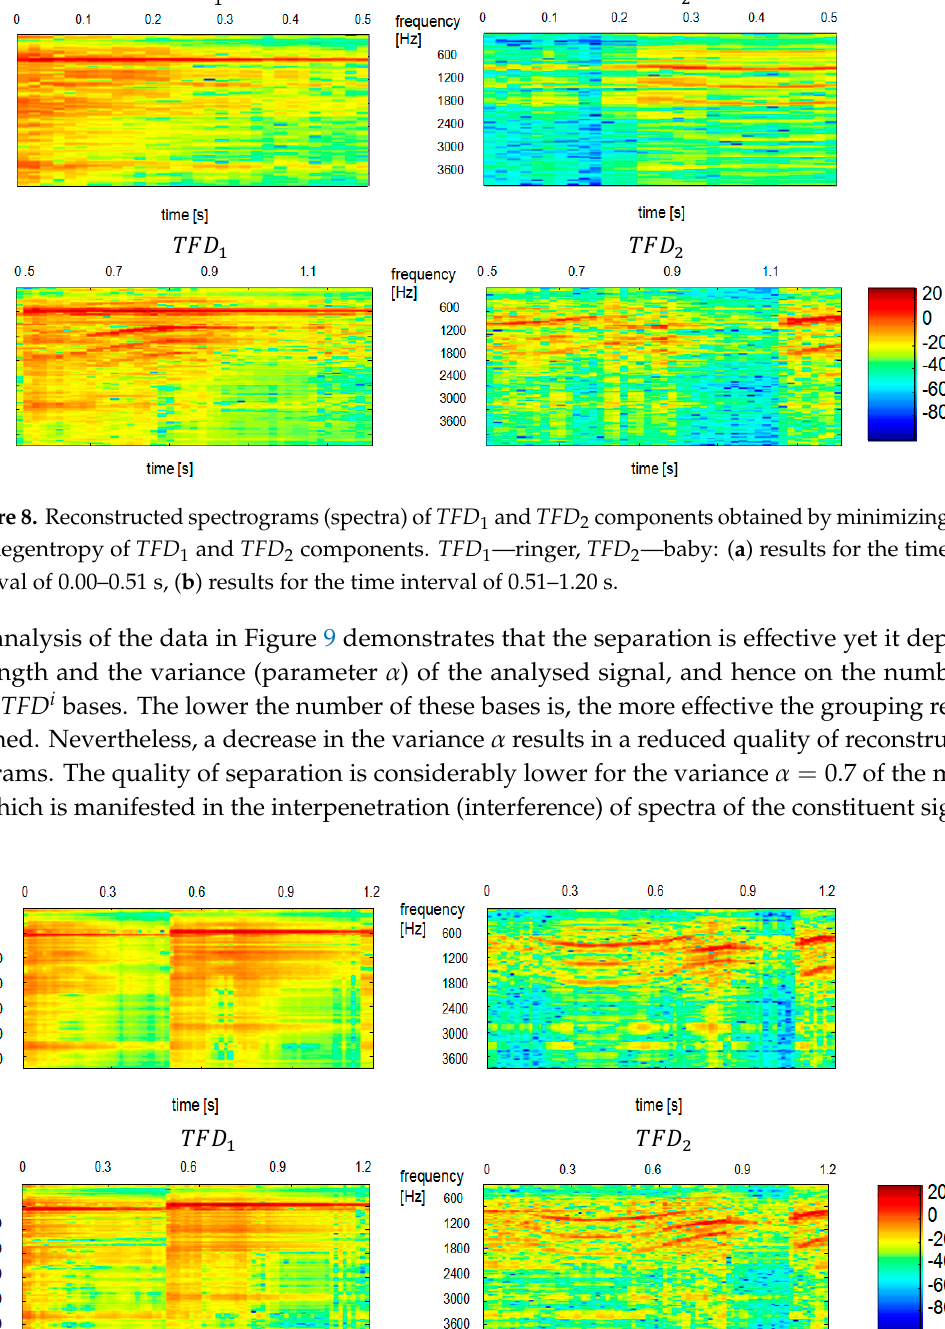
hierarchical clustering with Euclidean distance for 𝑇𝐹𝐷 (cid:3036) components. 𝑇𝐹𝐷 (cid:2869) —ringer, 𝑇𝐹𝐷 (cid:2870) —baby: